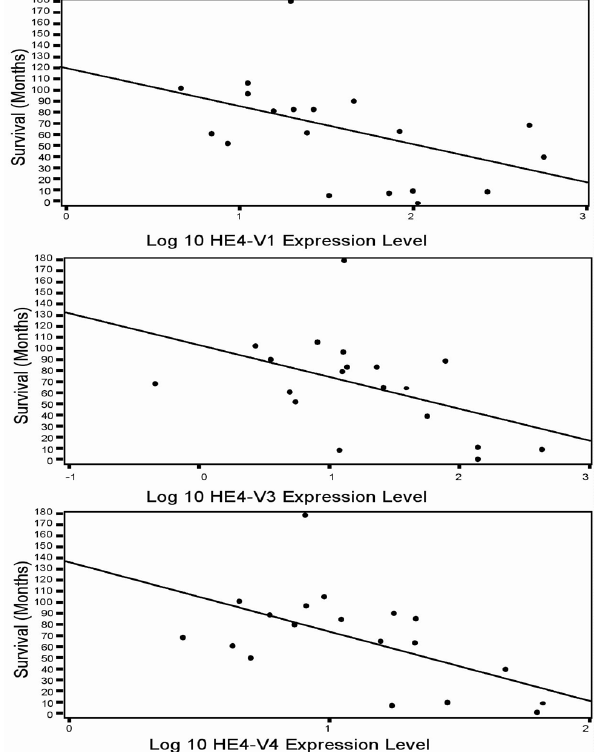
Figure 6. Correlation between HE4 variants mRNA levels and EC patient survival time. A significant inverse correlation was found between HE4-V1, -V3, -V4 mRNA levels and EC patient survival time in this endometrioid cancer sub-cohort ( p = 0.031, p = 0.048, p = 0.01, respectively, n =